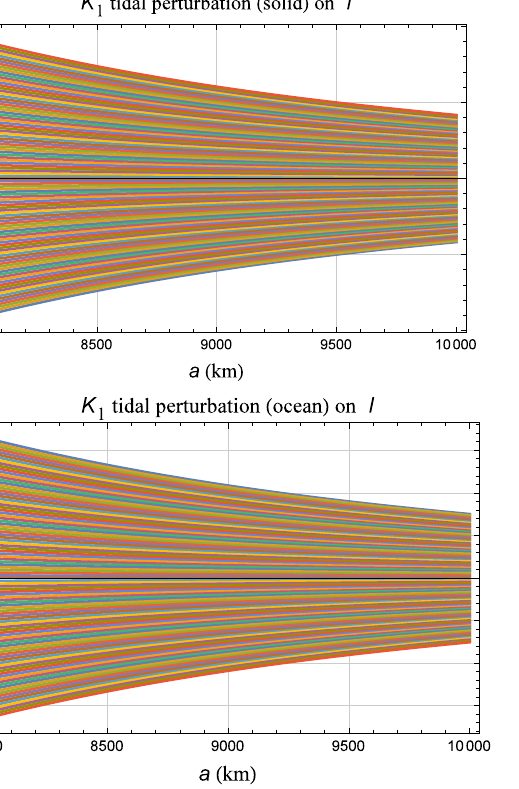
( 0 ) , C + levels of mismodeling in k are about (cid:2) 10 − 3 [30] or 2 , 1 , K 1 2 , 1 , K 1 3 × 10 − 4 [35], and 4 × 10 − 2 [42] or, perhaps, even better ( (cid:2) 10 − 3 ) if the global ocean models TPXO.6.2 [21], GOT99 [56] and FES2004 [48] are compared, respectively ◦ . The current